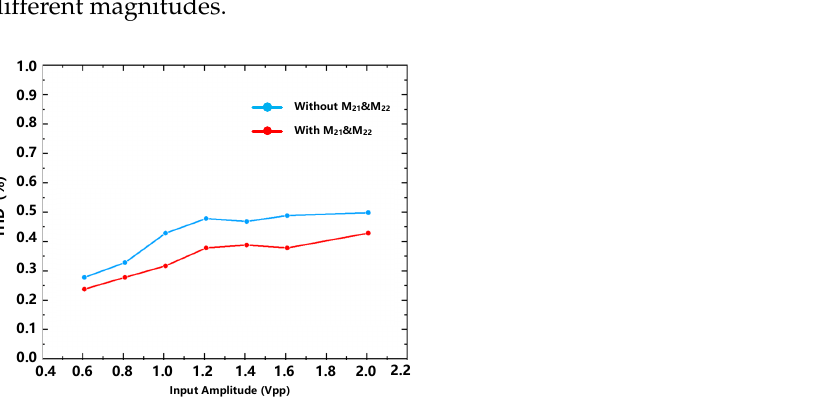
Figure 9. THD (Total Harmonic Distortion)(%) versus input amplitude with/without C N . From Section 2.2, we can conclude that the gain of the amplifier of the first stage integrator should be sufficiently large. We use a cross-coupled FFMC amplifier to obtain higher DC gain [22,23]. The schematic diagram of the amplifier is shown in Figure 7. To further verify the performance of the first OTA, the specification of gain, PM, IRN, and UGB has been simulated with 27 conditions, including different process corners (tt/ss/ff), temperature ( − 40/30/80), and voltage (4.8/5/5.2 V). the simulation result is shown in Figure 10. With a 5pF load capacitance, the OTA achieved a 121.71 dB DC gain, 75.49 dB phase-margin, and 20.65 MHz unity-gain-bandwidth with 17.85 nV